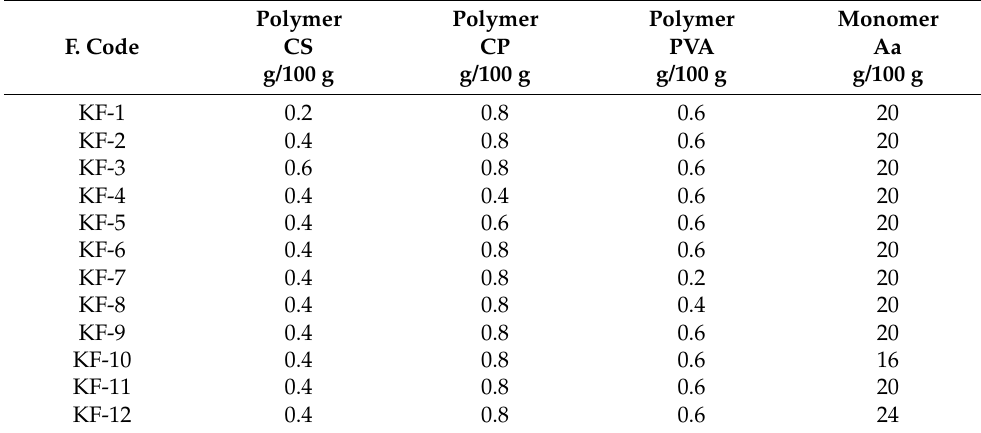
Table 1. Feed ratio scheme for formulation of CS/CP/PVAcPAa hydrogels.